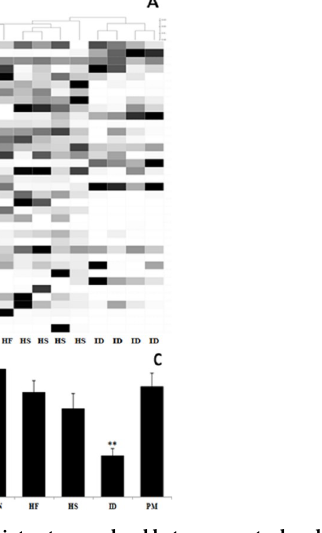
Fig 2. Comparison of the gut microbiota at genus level between control and experimental groups. (A) heatmap, (B) relative abundance, (C) alpha diversity. CON, control; HF, high fat; HS, high sucrose; ID, iron deficiency; PM, processed meat. Values are expressed as mean ± SEM. Statistical significance compared to control was accepted at � P < 0.05, �� P < 0.01.